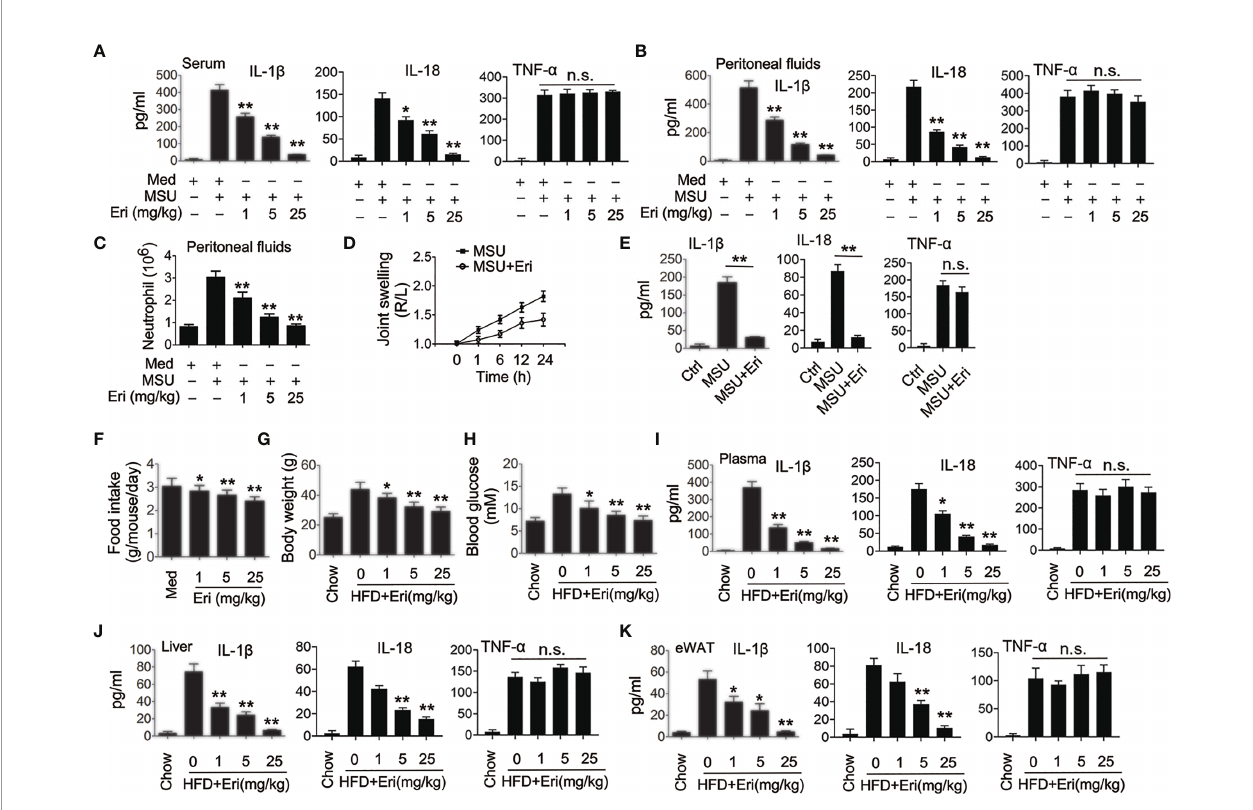
FIGURE 2 | Eri inhibits NLRP3 activation in vivo. (A, B) C57BL/6 mice were intraperitoneally injected with the indicated concentrations of Eri for 12 h. Then, mice were intraperitoneally injected with MSU (1 mg/mouse) for 6 h. IL-1 b , IL-18 and TNF- a protein levels in serum (A) or peritoneal fl uids (B) were determined by ELISA. (C) Experiments were performed as described in (B) , except neutrophil numbers in the peritoneal cavity were analyzed using FACS. (D) C57BL/6 mice were intraarticularly injected with Eri (0.5 mg/kg) for 1 h. Then, mice were intraperitoneally injected with MSU (0.5 mg/mouse). Joint swelling was measured at the indicated time. (E) C57BL/6 mice were intraarticularly injected with Eri (0.5 mg/kg) for 1 h.Then, mice were intraperitoneally injected with MSU (0.5 mg/mouse) for 24 h. IL-1 b , IL-18 and TNF- a protein levels in joint culture were determined by ELISA. (F – H) C57BL/6 mice were fed with HFD for 12 weeks. Then, the mice were treated with the indicated concentrations of Eri every other day for 4 weeks. Food intake (F) and body weights (G) were recorded and blood glucose levels (H) were measured. (I) Experiments were performed as described in (F) , except IL-1 b , IL-18 and TNF- a protein levels in plasma were determined by ELISA. (J, K) C57BL/6 mice were fed with HFD for 12 weeks. Then, the mice were treated with the indicated concentrations of Eri every other day for 4 weeks. Liver (J) and white adipose tissue (WAT) (K) were isolated and cultured for 24 h. IL-1 b , IL-18 and TNF- a protein levels in supernatants were determined by ELISA. Bar graphs present means ± SEM, n = 5 for each group (**P < 0.01; *P < 0.05). n.s., not signi fi